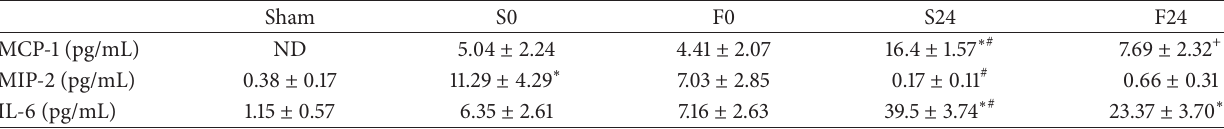
Table 2: Plasma concentrations of the